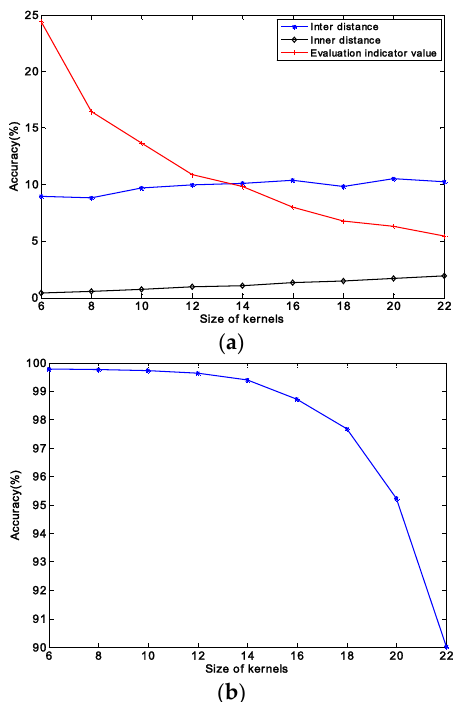
Figure 9. The classification accuracy influence with the kernel size. ( a ) the evaluation indicator value, the inter distance and inner distance with different kernel sizes on Dataset 2; ( b ) the classification accuracy with the evaluation indicator value on Dataset 2.